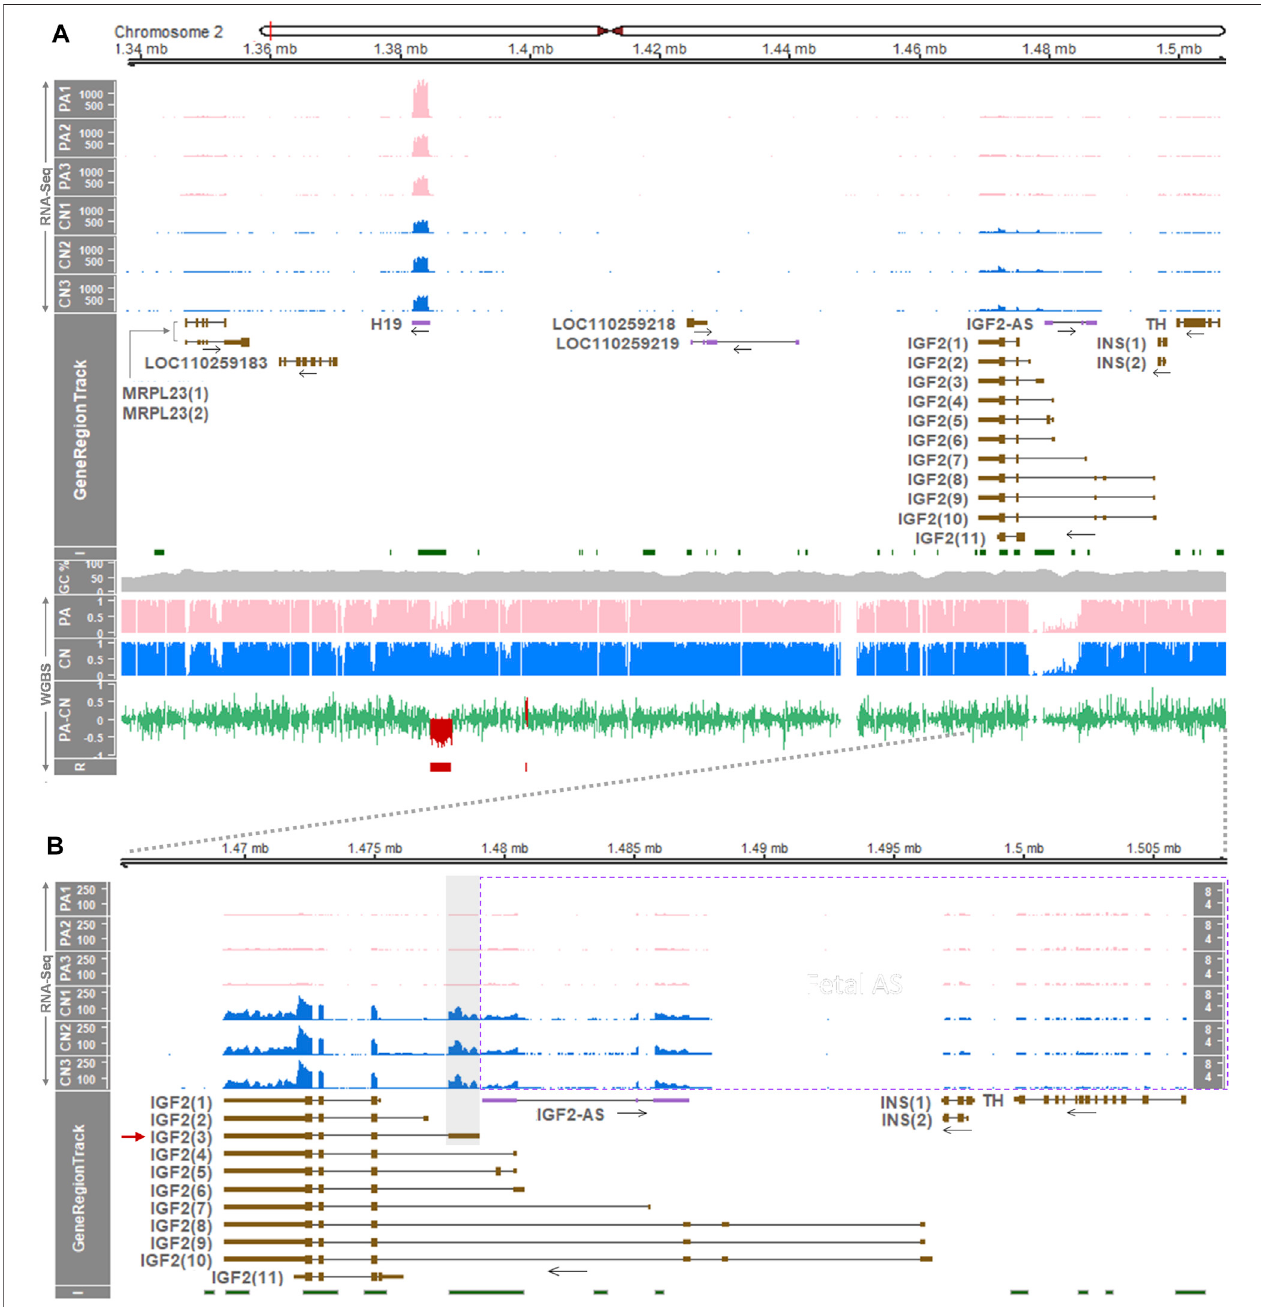
FIGURE1| GeneexpressionandDNAmethylationpro fi lingatthe H19 / IGF2 locusintheporcineembryo. (A) AboveGeneRegionTrack,normalizedreadcoverages from RNA-Seq are shown as transcripts per million (TPM; y-axis) in each track of PA and CN embryos. In GeneRegionTrack, genes located in the 0.171-Mb (171-Kb) regionbetweenthe MRPL23 and TH genes(chr2:1,337,000-1,508,000)aredisplayedbyeitherbrownboxes[tall,translatedregions;short,untranslatedregions(UTRs)] forprotein-codingtranscriptsorpurpleboxesfornon-codingtranscripts.Thedirectionsoftranscriptionaremarkedbyhorizontalarrows.BelowGeneRegionTrack, averages of cytosine methylation ratios ( n = 3, PA and CN each) obtained by WGBS are shown. PA-CN indicates mean methylation ratios of PA subtracted by those of CN. R represents DMRs called by the metilene software (FDR < 0.05) which are also overlaid in the PA-CN track. I (CpG islands) and GC% (GC content) were derived from the UCSC Table Browser. (B) The locus spanning IGF2 , IGF2-AS , INS , and TH genes (43-Kb, chr2:1,465,000-1,508,000) were zoomed in. For IGF2-AS , INS , and TH ,expressionisdisplayedwithinadottedrectangleandanadditionaly-axis(TPM)isshownatthefarright.Piggenetranscriptsinclude MRPL23(1) ,XM_021083608.1; MRPL23(2) , XM_021083607.1; IGF2(1) , XM_021080593.1; IGF2(2) , XM_021080637.1; IGF2(3) , XM_021080576.1; IGF2(4) , XM_021080612.1; IGF2(5) , XM_021080582.1; IGF2(6) , XM_021080648.1; IGF2(7) , XM_021080641.1; IGF2(8) , XM_021080607.1; IGF2(9) , XM_021080643.1; IGF2(10) , XM_021080603.1; IGF2(11) , XM_021080596.1; INS(1) , XM_021081278.1; INS(2) , NM_001109772.1.